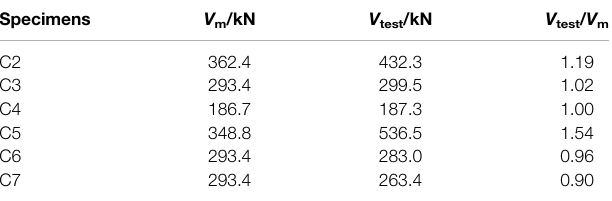
TABLE 4 | Comparison of analytical and experimental results.